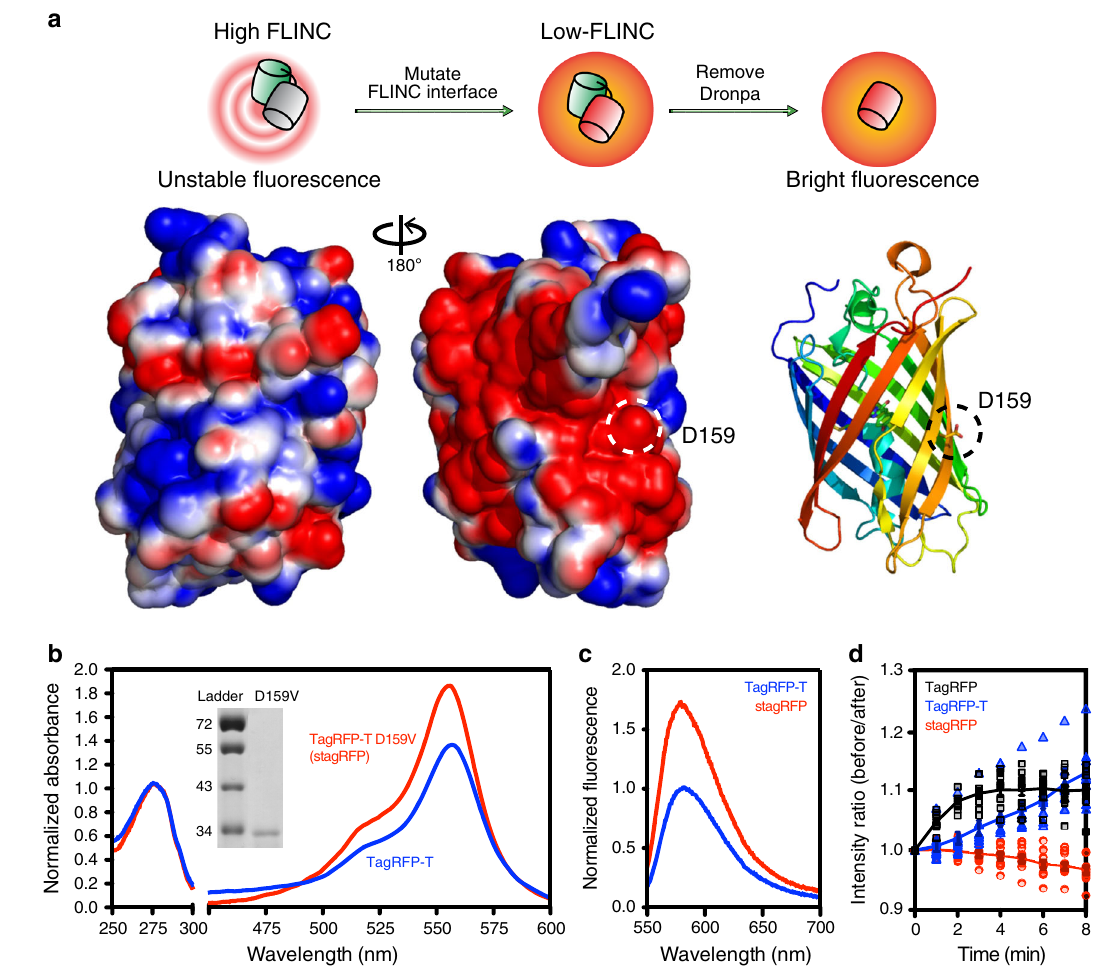
Fig. 1 The rational mutagenesis model and the resulting enhanced spectroscopic characteristics of stagRFP compared to TagRFP-T. a Schematic underlying the rational engineering approach. A model system bearing high FLINC state reveals the presence of the external acidic residue that weakens the TagRFP-T chromophore. Site-directed mutagenesis products that rescue the model back to a low FLINC state harbor mutants with improved insulation and stable fl uorescence. Finally, removal of Dronpa con fi rms the improved behavior of the mutant TagRFP-T. A ribbon structure and APBS electrostatic surface of TagRFP-T (based on PDB 3T6H) demonstrates the large acidic (red) solvent exposed surface opposite the chromophore. The location of D159 is indicated by dashed circles. Normalized in vitro absorption ( b ) and fl uorescence ( c ) spectra of puri fi ed stagRFP compared to TagRFP-T demonstrating the signi fi cantly higher extinction coef fi cient and quantum yield. d Cyclic excitation of HeLa cells expressing different TagRFP variants show photoactivation is present in parent proteins (TagRFP and TagRFP-T), but not the new mutant stagRFP (TagRFP, n = 9 biologically independent cells; TagRFP-T, n = 10; and stagRFP, n = 12 biologically independent cells); each cell is represented by the, respectively, colored symbol, and the average values across all cells are shown using solid lines. Source data for b – c are provided as a Source Data fi stagRFP as the FRET pair and a semi- fl exible linker (AKARev), displayed a further improvement resulting in an average response of 44.6 ± 2.1% ( n = 37, maximum dynamic range of 80%) that is 6-fold better than the average response of 8.1 ± 0.9% ( n = 32) of the current best green-red biosensor AKAR2-CR, 10 utilizing the FRET pair mClover and mRuby, in the same cell lines (Fig. 2a). The new green-red GR-AKAR3 is comparable to the cyan-yellow PKA activity reporter AKAR4 8 .